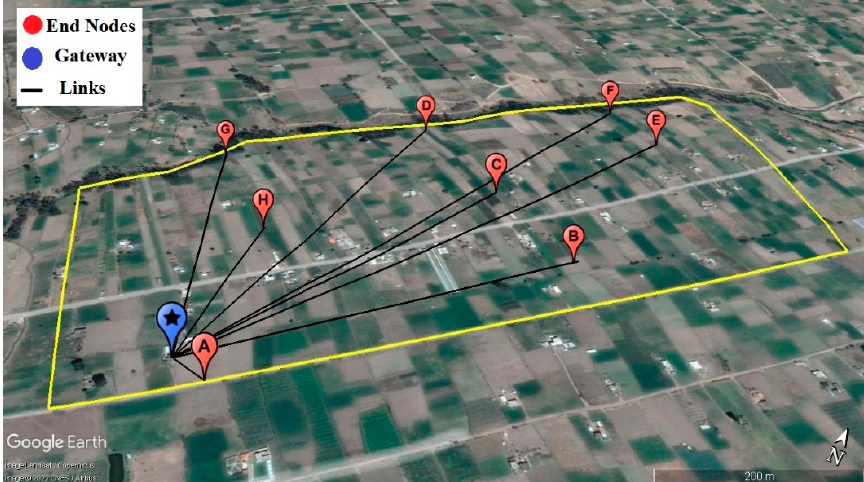
Figure 7. Spatial distribution of nodes and gateway on the digital surface elevation model, Chirinche Bajo community, Salcedo, Ecuador.